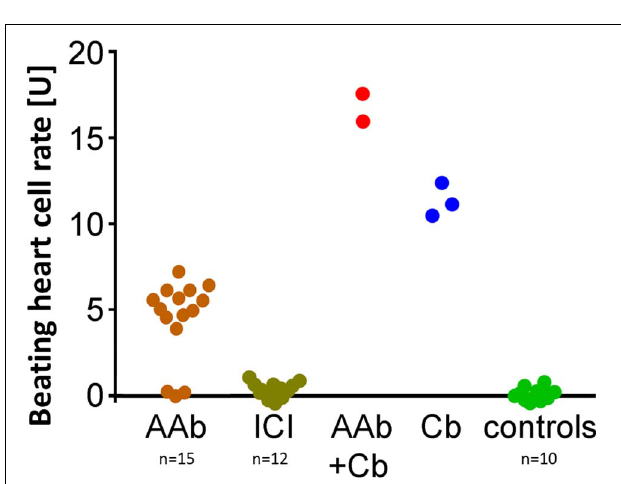
FIGURE 6 | Synergistic β 2 -AAbs enhanced the effect of Cb alone and enhanced the agonistic effect of β 2 -agAAbs. Beating cell rates after incubation of live rat cardiomyocyte cells with patient sera from PEX glaucoma (PEXG): sera without (orange) and with the β 2 -blocker ICI-118,551 (gray–green); synergistic β 2 -AAbs (red) after coincubation of the beating heart cells with clenbuterol (Cb); reference: beating heart cell rate after incubation with clenbuterol alone (blue) and of control subjects (green). One unit (U) reflects 4 beats/min. Sera of PEX glaucoma showed synergistic and agonistic β 2 -AAbs: agonistic β 2 -AAbs were present as beating heart cell rates were increased compared to controls, reaching Cb effect alone. Synergistic β 2 -AAbs enhanced the effect of Cb alone and enhanced the agonistic effect of β 2 -agAAbs. ICI blocked the effect of the β 2 -adrenergic receptor AAbs demonstrating the specificity for the β 2 -adrenergic receptor on the beating heart